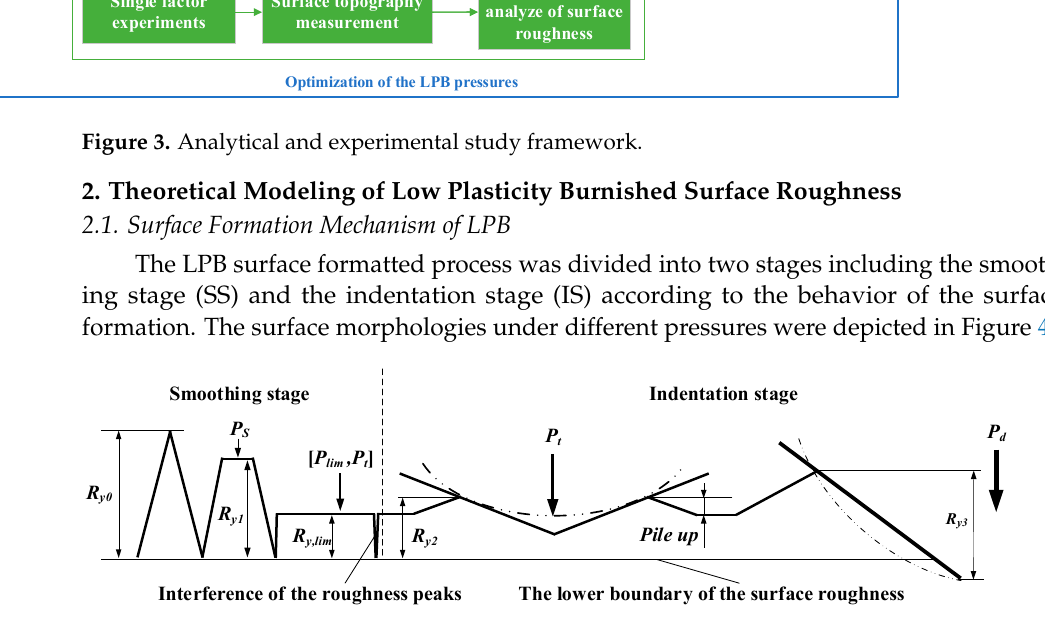
Figure 4. Surface morphologies after smoothing stage and indentation stage.